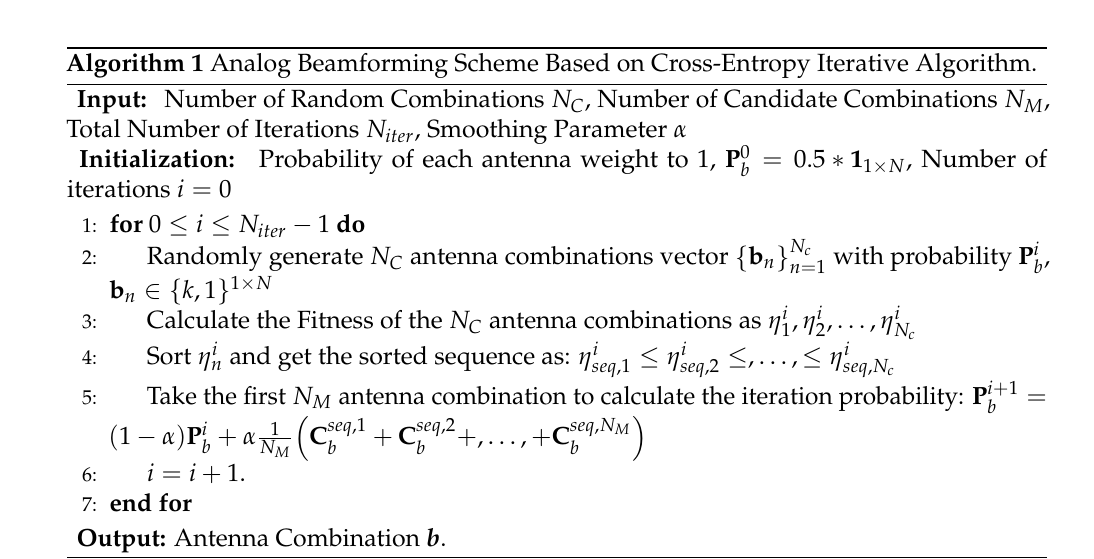
Random Selection Algorithm CE Optimal Algorithm